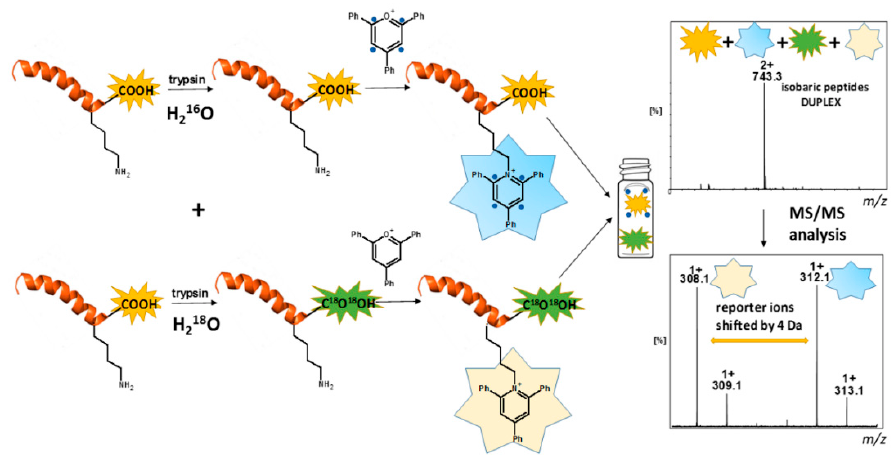
Figure 14. Scheme presenting the formation of a pyridinium-based duplex (the blue circle indicates the 13 C labeling) [70].